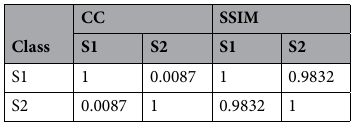
Table 1. CC and SSIM of output maps corresponding to different input bands.